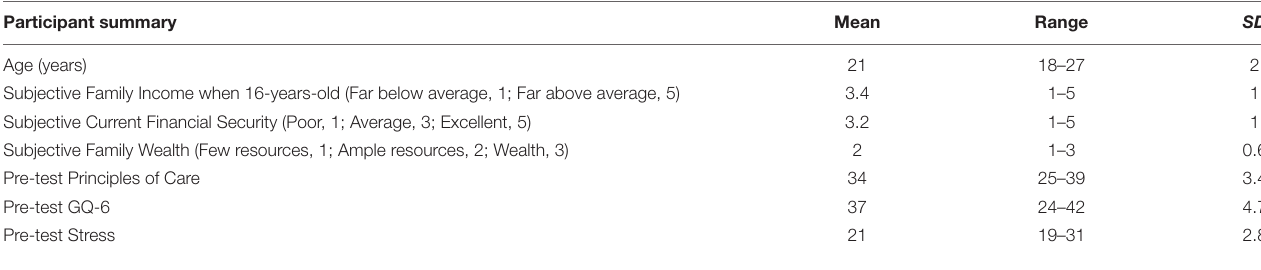
TABLE 1 | The 33 participants randomly assigned to Gratitude ( N = 16) and Active-Neutral ( N = 17) groups did not differ in age, income, or pre-test gratitude, pre-test care, or stress measures [all T (31) < 1.9, p > 0.05]. Participant